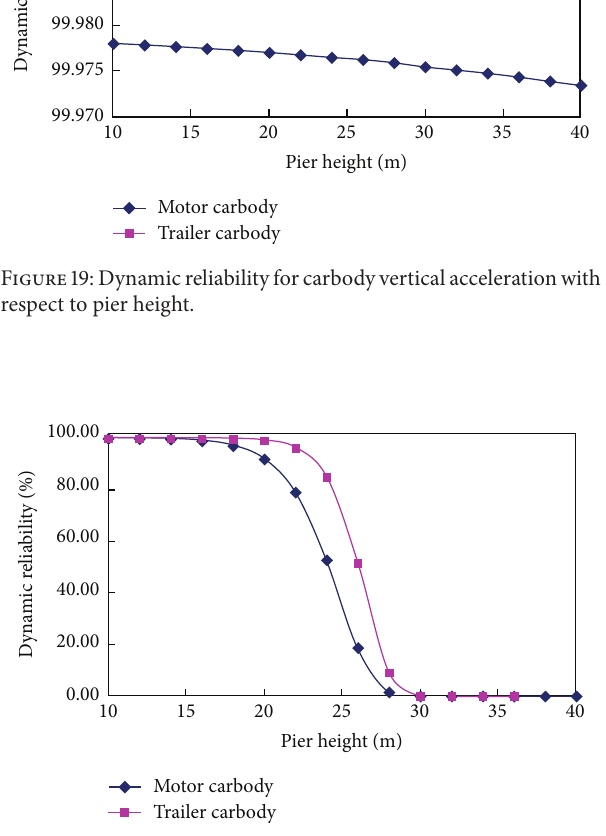
Figure 17: Dynamic reliability for lateral wheelset force with respect to seismic acceleration.